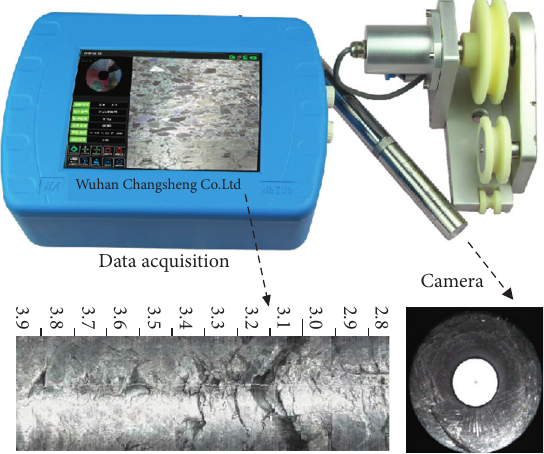
Figure 11: Application of drilling camera